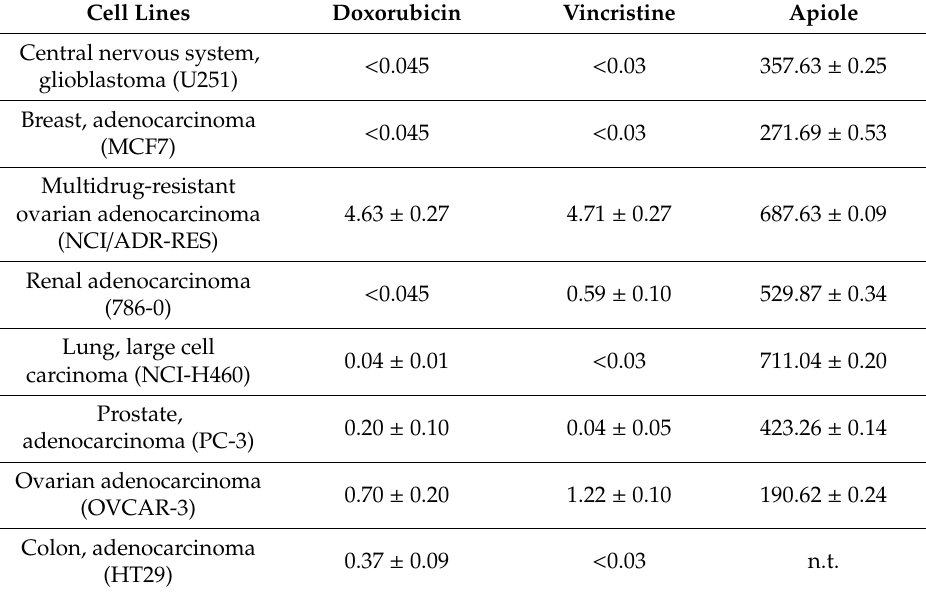
Figure 2. Antiproliferative profiles of apiole ( A ) and the chemotherapeutic drugs doxorubicin ( B ) and vincristine( C )againstahumancelllinepanelafter48hexposure. Humantumorcelllines: U251—central nervous system, glioblastoma; MCF7—breast, adenocarcinoma; NCI / ADR-RES—multidrug-resistant ovarian adenocarcinoma; 786-0—renal adenocarcinoma; NCI-H460—lung, large cell carcinoma; PC-3—prostate, adenocarcinoma; OVCAR-3—ovarian adenocarcinoma; HT29—colon, adenocarcinoma. Concentration range: apiole (1–1000 µ M); doxorubicin (0.045–45 µ M) and vincristine (0.03–30 µ M). Table 2. Antiproliferative activity a of apiole and the chemotherapeutic drugs doxorubicin and vincristine against human cell line panel after 48 h exposure, expressed as GI 50 b